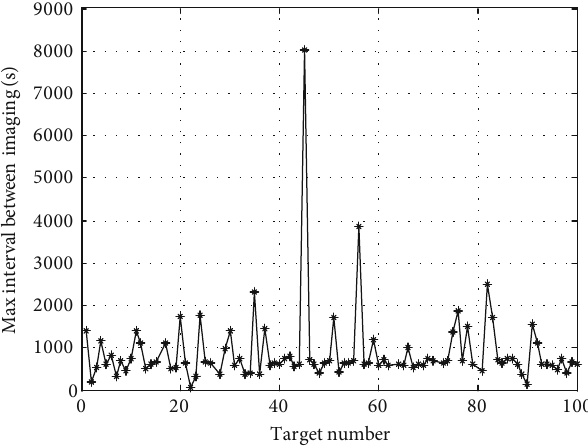
Figure 18: Simulation result of 100 groups of sensitive target